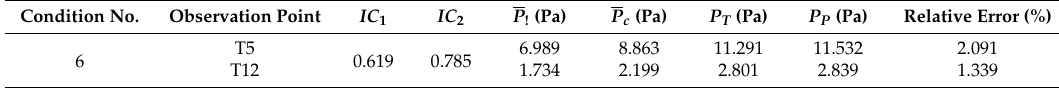
Table 7. Verification of influence coefficients of multi vibration sources of